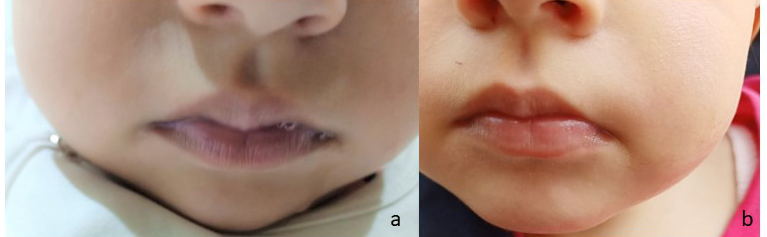
Figure 1. Pictures of patient before ( a ) and after ( b ) treatment with ascorbic acid showing complete resolution of the cyanosis of the lips (performed at 15 months and 20 months of age, respectively).